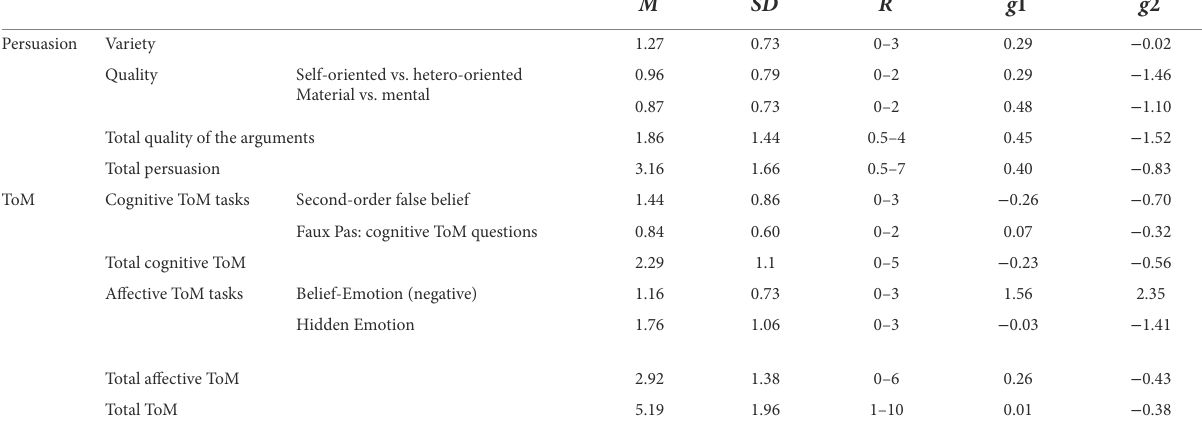
of age and total score in persuasion was not significant in Table 3. As for the specific correlations of each of the ToM components with age and persuasion, the results showed that affective ToM evinces a positive and statistically significant correlation with age [ r xy = 0.27, p < 0.01] as well as with persuasion [ r xy = 0.32, p < 0.01]. However, the correlations of cognitive ToM total score and both age and persuasion were not significant.